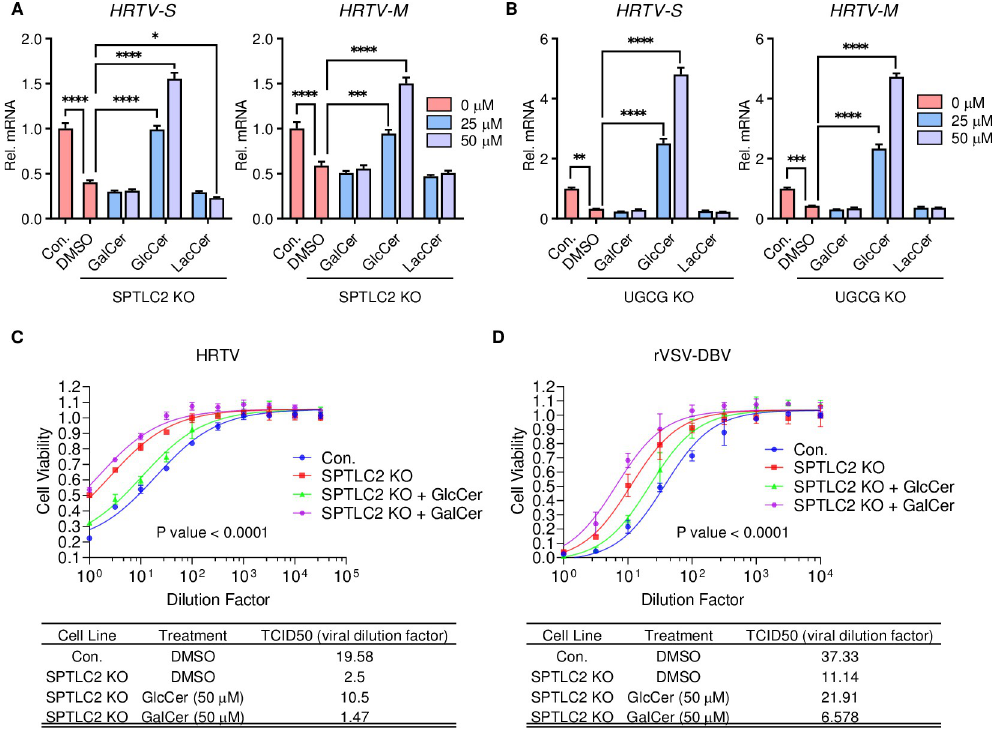
Fig 5. Supplementing with GlcCer enhances HRTV infection. A-B. Exogenous glycosphingolipid supplement for HRTV replication in SPTLC2 or UGCG KO 293T cells. Cells were cultured in media supplemented with 0–50 μ M indicated glycosphingolipid for 24 hours before HRTV infection (MOI = 1). Viral RNA levels were measured at 24 hours post- infection. Control cells without glycosphingolipid supplement was shown for comparison. Data shown are means ± SEM from representative experiments (n = 3 technical replicates). P values were determined by ordinary one-way ANOVA with Dunnett’s multiple comparison tests. ���� , P < 0.0001; ��� , P < 0.001; �� , P < 0.01; � , P < 0.05. C-D. TCID 50 of HRTV and rVSV-DBV in SPTLC2 knockout cell with GalCer or GlcCer supplement. Cells were cultured in media supplemented with 50 μ M indicated glycosphingolipid for 24 hours before HRTV or rVSV-DBV